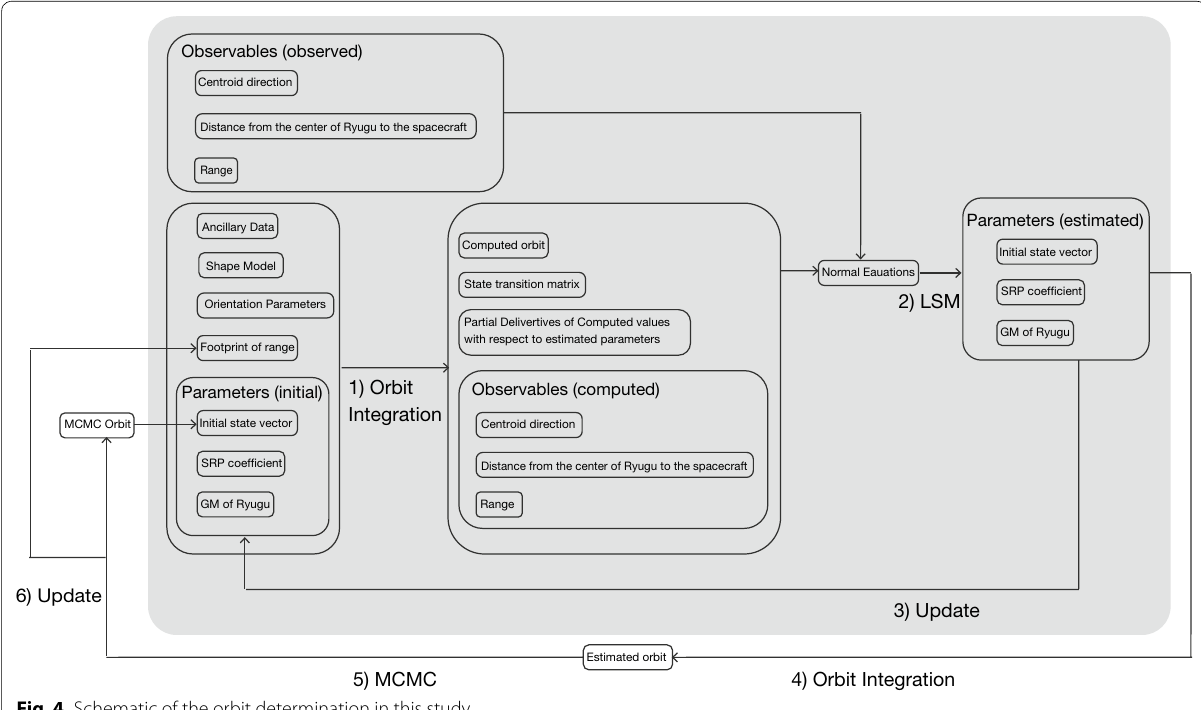
Fig. 4 Schematic of the orbit determination in this